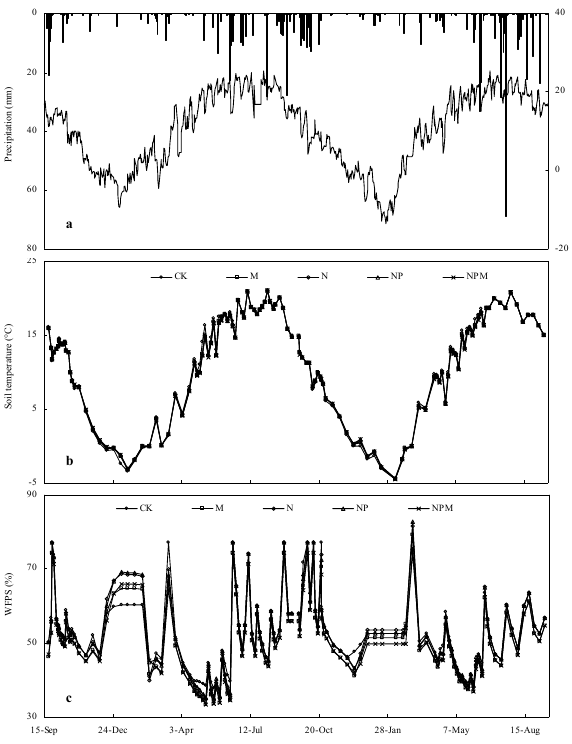
Fig. 1. Precipitation and air temperature (a), 5 cm depth soil tem- perature (b) and WFPS (c) for different fertilization treatments from September 2006 until September 2008.